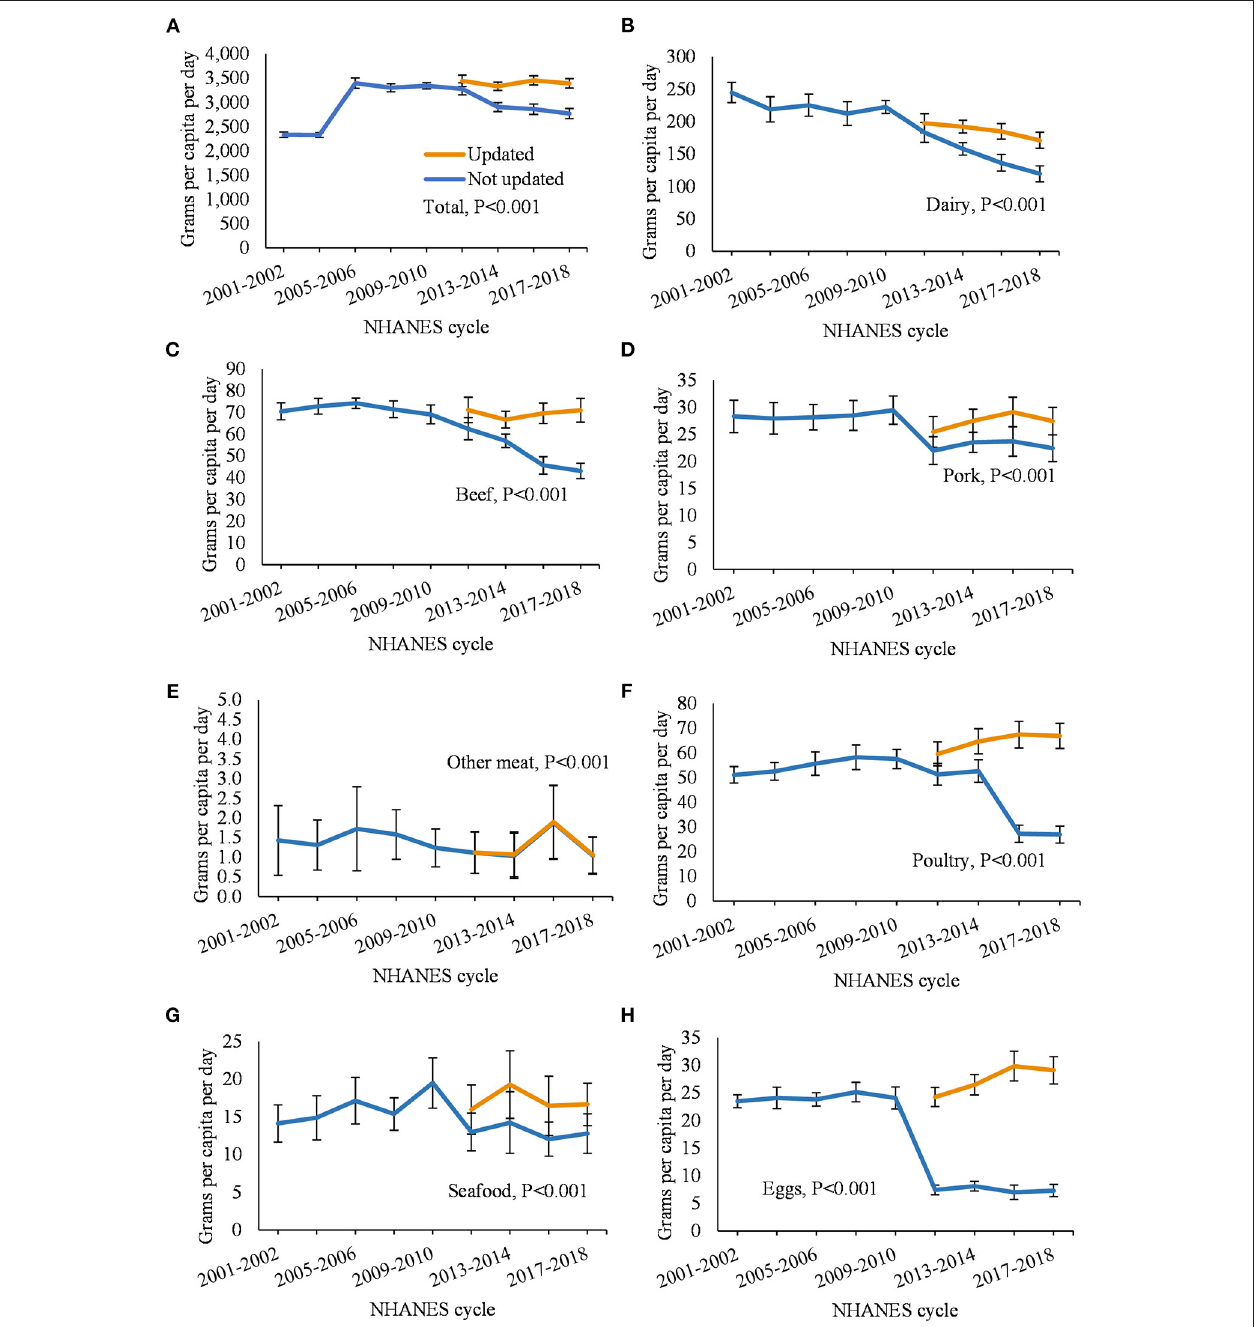
FIGURE 1 | Annual per capita food intake among US adults from 2001 to 2018 comparing updated and non-updated Food Commodity Intake Database (FCID). (A) total; (B) dairy; (C) beef; (D) pork; (E) other meat; (F) poultry; (G) seafood; and (H) eggs. FCID, Food Commodity Intake Database. Differences between trend lines were evaluated using paired Wald tests adjusted for age, gender, energy intake. Data from 2009 to 2010 were used as the regression intercept.